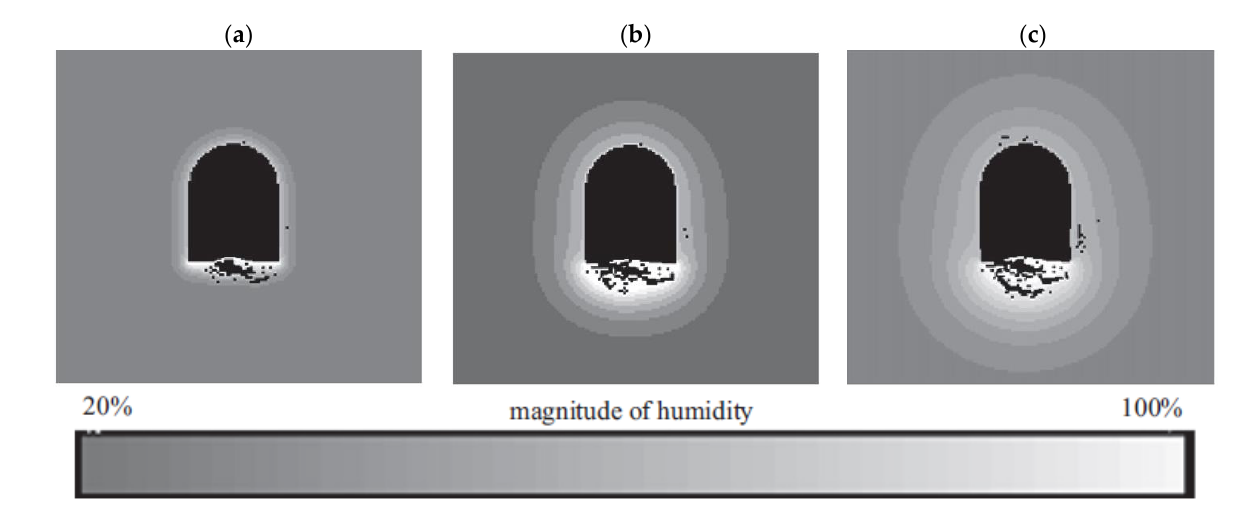
Figure 3. Moisture diffusion processes during floor heave associated with failure evolution ( a ) after 10 days, ( b ) after 30 days, and ( c ) after 70 days [28].